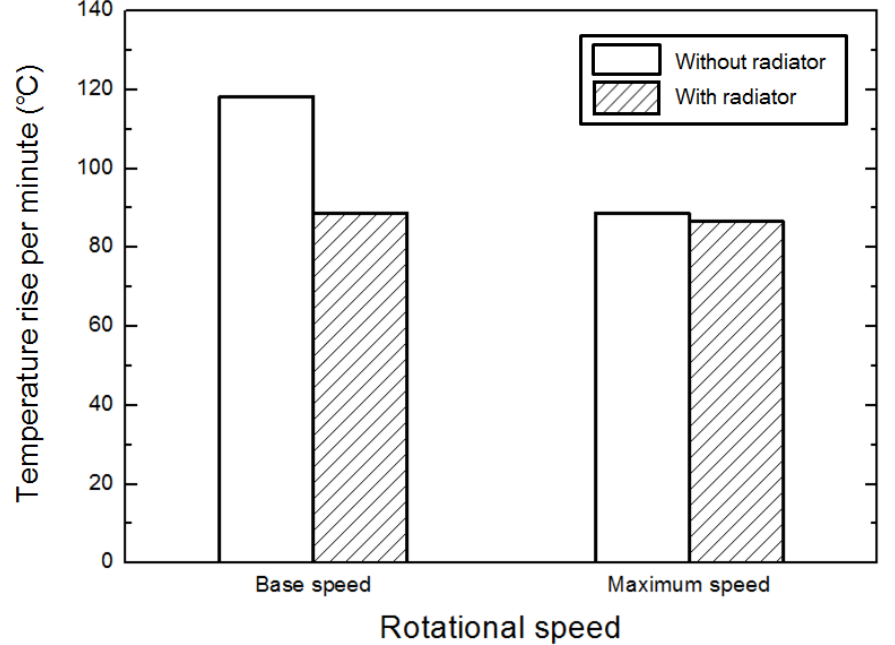
Figure 7. Temperature rise per minute with respect to motor cooling systems under maximum rating